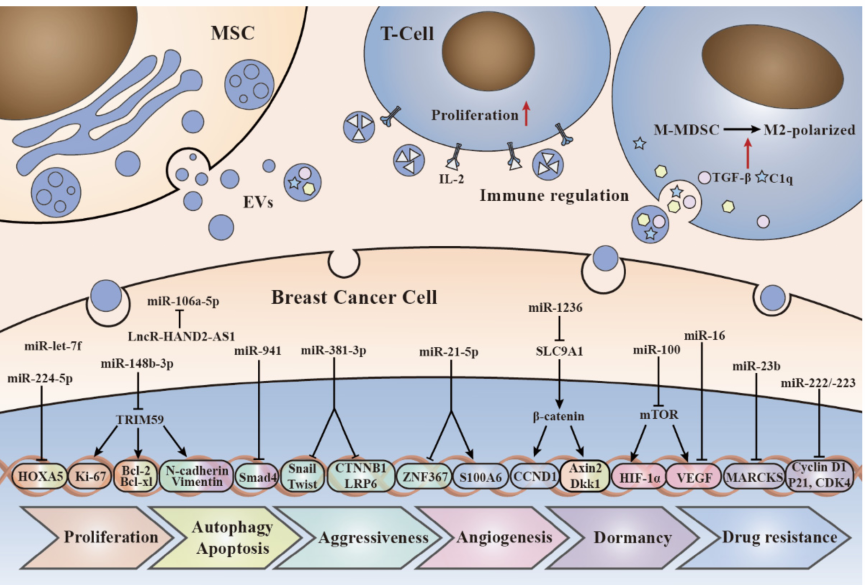
Figure 2. The molecular mechanisms of MSC-EVs cargos in breast cancer development. This figure depicts how the EVs interact with the recipient cells and the molecular mechanisms by which cargos loaded in EVs affect breast cancer cells, including proliferation, autophagy, apoptosis, aggressiveness, angiogenesis, immune regulation, dormancy, and drug